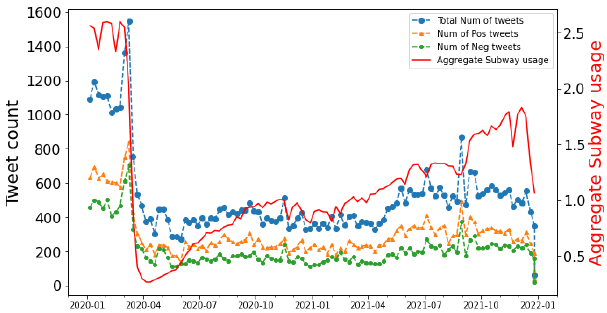
Figure 3. Subway.